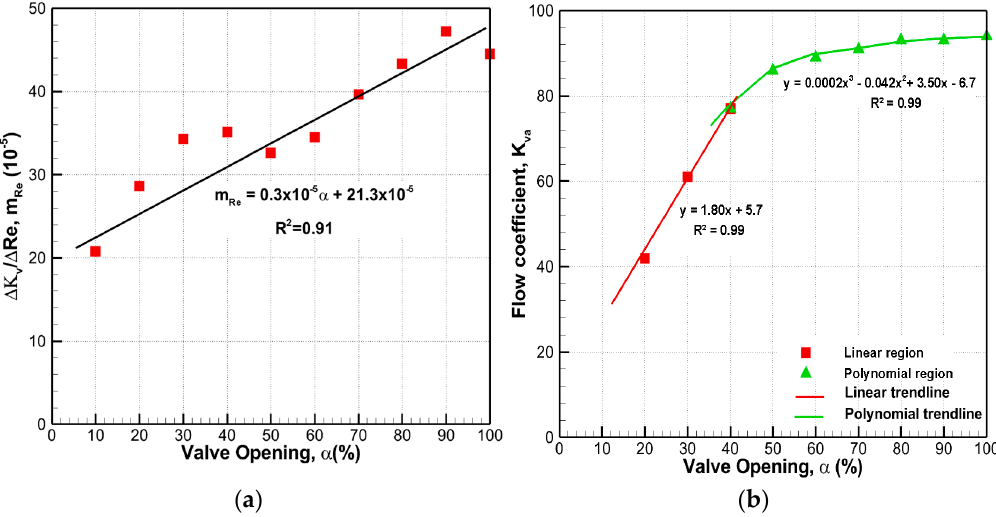
Figure 14. Flow coefficient characteristics with respect to valve opening: ( a ) slope of the linear Figure 14. Flow coe ffi cient characteristics with respect to valve opening: ( a ) slope of the linear trendlines trendlines of linear regions; ( b ) average flow coefficients of constant regions. of linear regions; ( b ) average flow coe ffi cients of constant